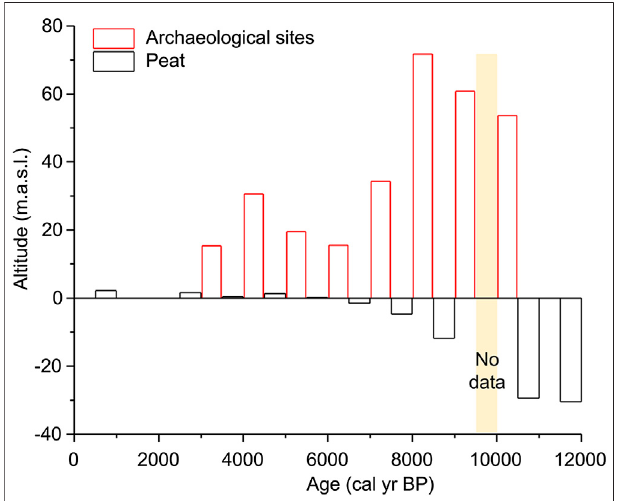
FIGURE3| Averagealtitudeper1,000 yearsofradiocarbondatesofthe archaeological sites and peat.